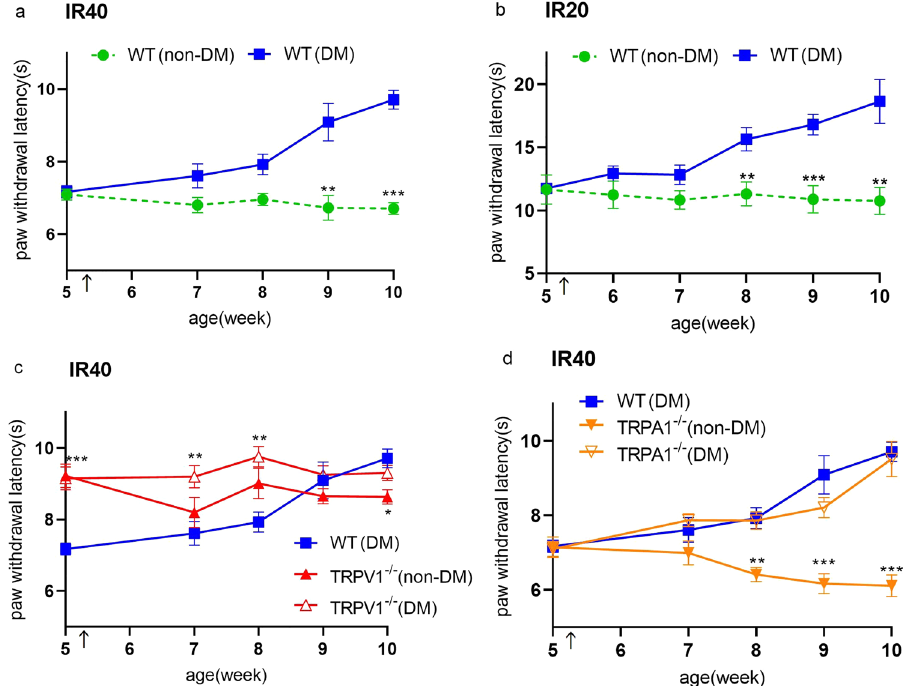
Figure 2. Changes in paw withdrawal latency in WT (DM), TRPV1 −/− (non-DM) and TRPA1 −/− (non-DM) mice. ( a,b ) Changes in paw withdrawal latency (PWL) by IR intensity 40 ( a ) and IR intensity 20 ( b ) before and after intraperitoneal injection of streptozotocin (STZ 150 mg/kg) or an equal volume of citrate-buffer vehicle in 5-week-old wild-type mice (diabetic mellitus (WT (DM)), n = 8–9; non-diabetic (WT (non-DM)), n = 10). ( c ) Comparison of PWL by IR intensity 40 in WT (DM) (n = 9), TRPV1 −/− (non-DM) (n = 10), and TRPV1 −/− ( DM) (n = 8) mice. ( d ) Comparison of PWL by IR intensity 40 in WT (DM) (n = 9), TRPA1 −/− (non-DM) (n = 9), TRPA1 −/− (DM) (n = 8) mice. The PWL at 5 weeks of age was measured a few days before STZ and the buffer administration. Timing for STZ and the buffer administration is indicated by arrows. The data are presented as box-and-whisker plots. Two-way repeated measures ANOVA followed by a Bonferroni post hoc test. * p < 0.05, ** p < 0.01, *** p < 0.001 vs.